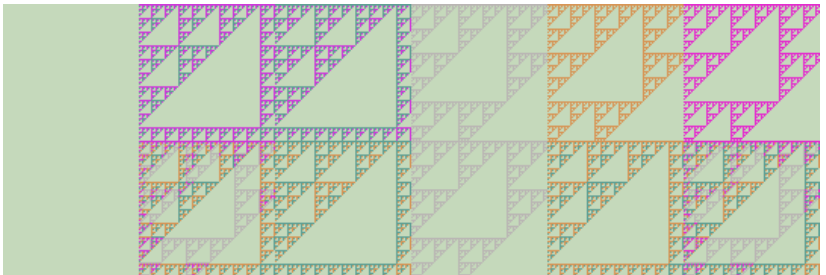
Figure 7. Standard sets of 90 × 90 image patterns associated to the dihedral group ( top ) and the abelian group ( bottom ) of order